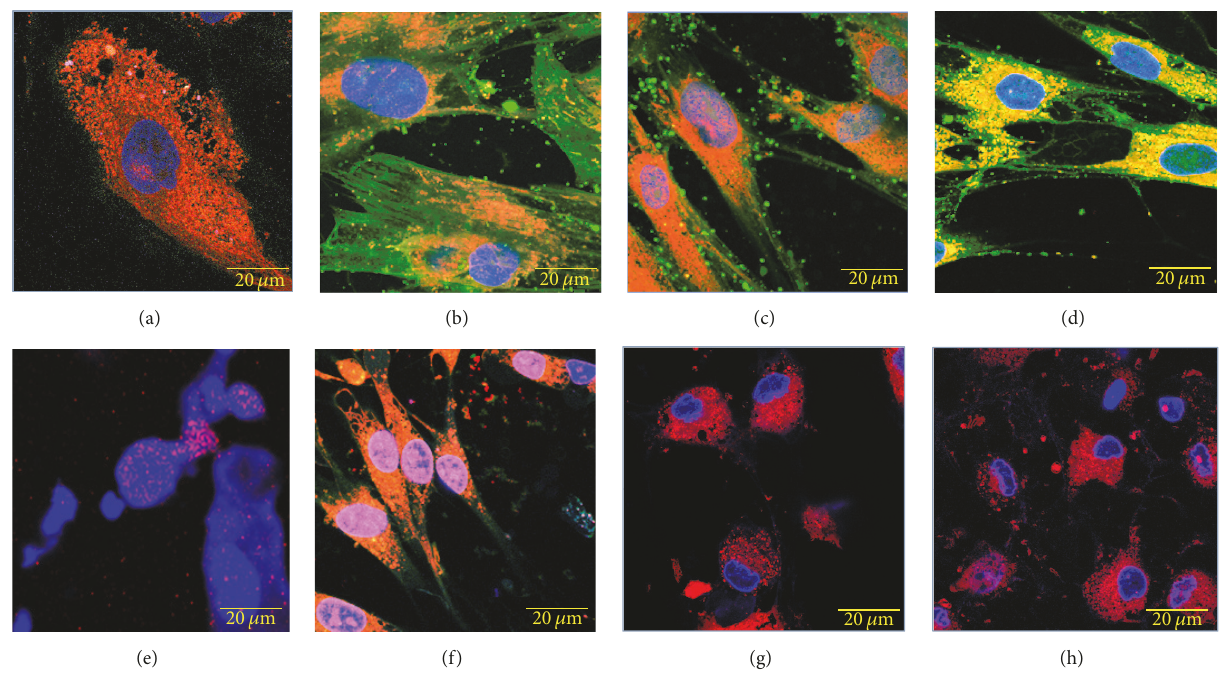
Figure 6: Cytotoxic effect on cultured dental pulp stem cells (DPSCs) exposed to 50 𝜇 moLL −1 CatDex-FITC and CHX for different amounts of time. (a) Negative control; (e) positive control. (b), (c), and (d): CatDex-FITC at 3 sec, 1h, and 5h, respectively. (f), (g), and (h): chlorhexidine at 3 sec, 1h, and 5 h, respectively. In red, emission of MitoTracker-H 2 XRos staining mitochondria; in blue, DAPI signal localised to the nuclear compartment; in green, CatDex-FITC signal localised to cytoplasm; and in orange, colocalisation of MitoTracker and FITC signals. Confocal laser microscope, fluorescent, histochemical technique, and objective